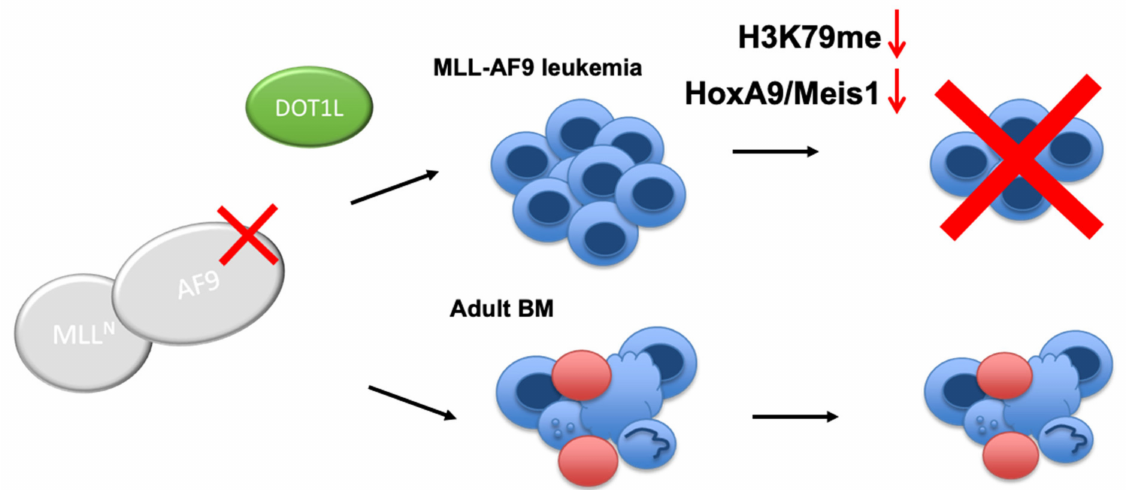
Figure 6. Proposed model for targeting the AF9-DOT1L interaction. Disrupting the AF9-DOT1L PPI downregulates H3K79me and HoxA9 and Meis1 expression leading to cell differentiation and cell death. In contrast, in non-leukemic bone marrow (BM), the AF9-DOT1L interaction is dispensable wherein hematopoietic stem and progenitor cells are